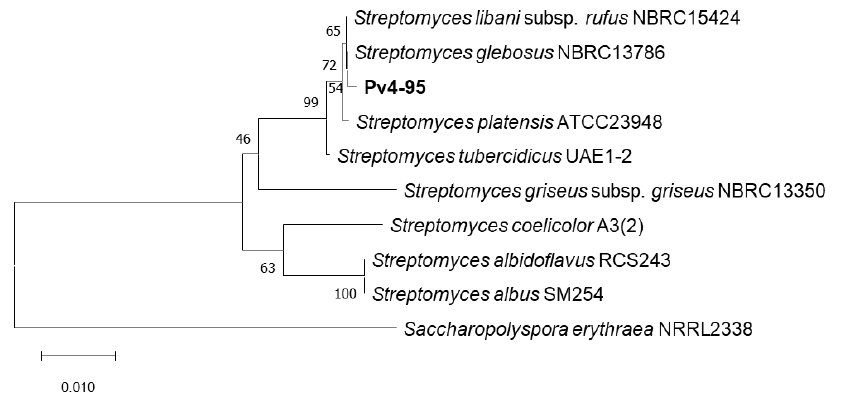
Figure 1. NJ tree based on 16S rRNA gene sequences from strain Pv 4-95 (in bold), their closest neighbours and several representative Streptomyces -type strains. Saccharopolyspora erythraea NRRL 2338 was used as an outgroup. Bar, 0.01 substitutions per nucleotide position. The heterologous adpA gene was introduced into the Pv 4-95 strain to activate the synthesis of secondary metabolites, which primarily exhibit antimicrobial activity. As a result, we obtained the exconjugate strain Pv 4-95 containing the recombinant plasmid pTESadpA. To compare the metabolic profiles of both strains, the secondary metabolite extracts were analysed by LC–MS using the wild-type strain Pv 4-95 and Pv